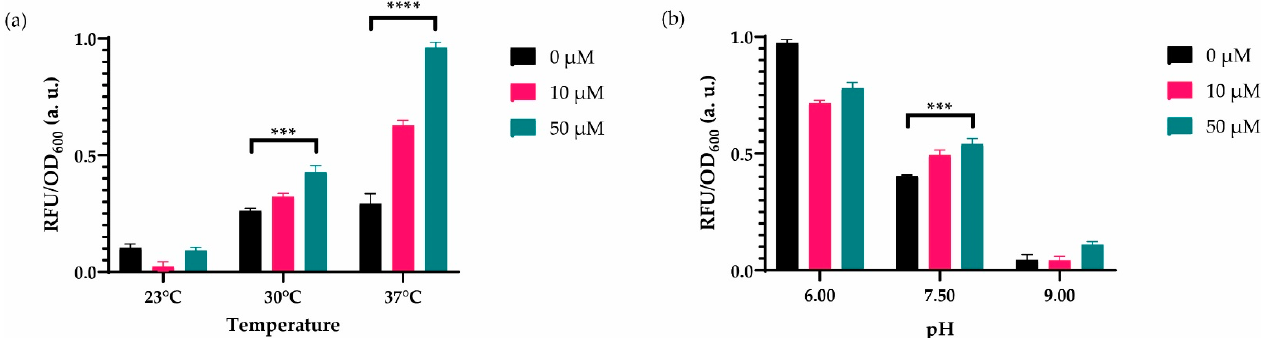
Figure 4. Dynamic range analyses for changing temperature and PH. ( a ) The recombinase-based biosensor was induced with 0 μ M, 10 μ M, and 50 μ M cadmium ion in incubators, in which temper- atures were 23°C, 30°C, and 37°C for 14 h. Measurements were conducted on 96-well plates. ( b ) The sensor was cultured in MOPS minimal media with pH varying 6, 7.5, and 9 for 14 h at 30°C in a stable incubator. For both ( a ) and ( b ), the initial number of cells was 1:50 of culture volume. The fluorescence intensity of each group was compared with each other and normalized according to the formula stated in the Materials and Methods section. Data were visualized with mean ± standard error mean (SEM) in each graph. At least three biological replicates were used for each analysis. For statistical analysis, multiple-t tests were implemented based on the group of interest. *** indicates p -value of <0.005, **** indicates p -value of <0.0005. Statistically nonsignificant results have no stars.